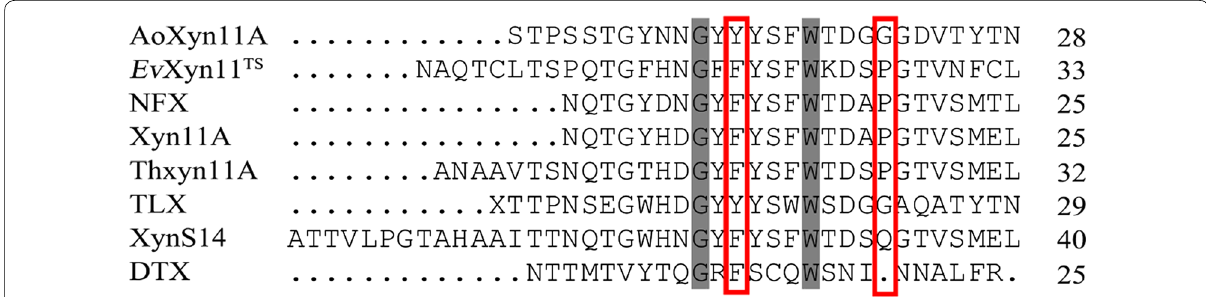
Fig. 2 The multiple alignment of the N‑terminal amino acid sequences of AoXyn11A and seven thermophilic GHF11 xylanases. The amino acids in positions 13 and 21, numbered by AoXyn11A, are highlighted in red solid line frame